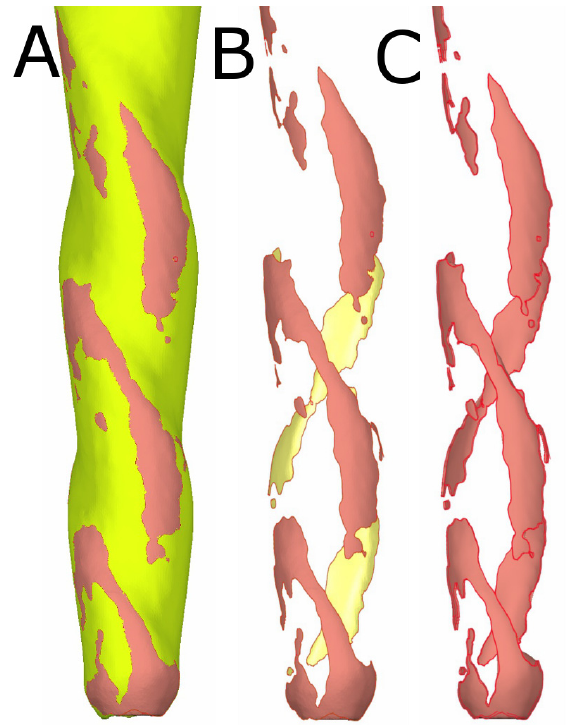
Figure 4. ( A ) Three-dimensional reconstruction of the aligned preoperative (yellow) and postoperative (red) digital files to isolate and measure the ( B ) wear area and ( C ) wear volume.